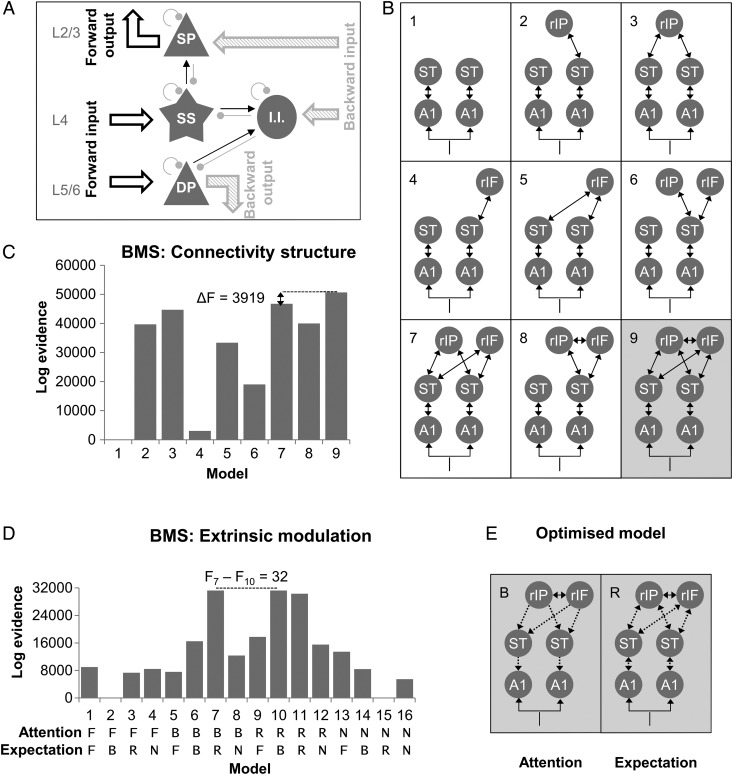
Dynamic causal modeling: optimizing the extrinsic connectivity structure. (A) All DCMs were based on a canonical microcircuit source architecture. Each source is modeled using 4 neuronal populations (spiny stellate cells in Layer 4, superficial and deep pyramidal cells in Layers 2/3 and 4/5, respectively, and inhibitory interneurons), linked by ordinary differential equations describing their current and voltage dynamics, and differing with respect to their intrinsic connectivity (with other populations; thin arrows, black: excitatory, red: inhibitory) and extrinsic connectivity (with other sources; thick arrows). The ascending extrinsic connections are considered excitatory and represent prediction errors, whereas the descending extrinsic connections are considered inhibitory and represent sensory predictions. Finally, each population is characterized by a gain parameter (inhibitory self-connections) encoding precision. (B) 9 alternative models were fitted to individual subjects' ERFs corresponding to the unattended auditory standards. All models included thalamic auditory input to bilateral A1 and differed with respect to the number of fronto-parietal sources and the extrinsic connectivity between them and the rest of the network. (C) Fixed-effects Bayesian model selection revealed that the model (shaded gray in the left panel) including both fronto-parietal sources (rIF: right inferior frontal gyrus; rIP: right intraparietal sulcus) and bilateral connectivity with the superior temporal gyrus sources (ST) outperformed all other models. (D) Modeling the contextual effects on extrinsic connectivity. 16 alternative models were designed, where each contextual factor (i.e., attention and expectation) could modulate a different subset of extrinsic connections between bilateral A1 and STG and between bilateral STG and the fronto-parietal sources: only feedforward connections (models “F”), only feedback connections (models “B”), both feedforward and feedback connections (models “R”), or no extrinsic connections (models “N”). Models were compared using fixed-effects Bayesian model selection. (E) The winning model had a posterior probability of >99% and allowed for both forward and backward connections to be modulated by expectation, but only the feedback connections to be modulated by attention.